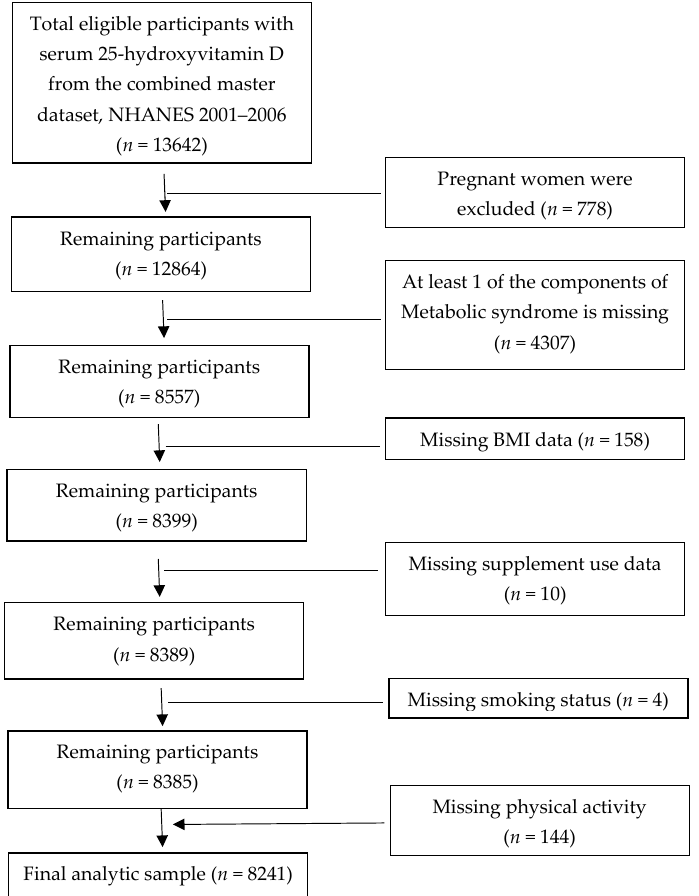
Figure 1. Strengthening of Reporting of Observational Studies in Epidemiology (STROBE) flow Figure 1. STROBE flow chart-sample derivation for the association between. chart-sample derivation for the association between serum 25-hydroxyvitamin D concentration and serum 25-hydroxyvitamin D concentration and prevalence of metabolic syndrome prevalence of metabolic